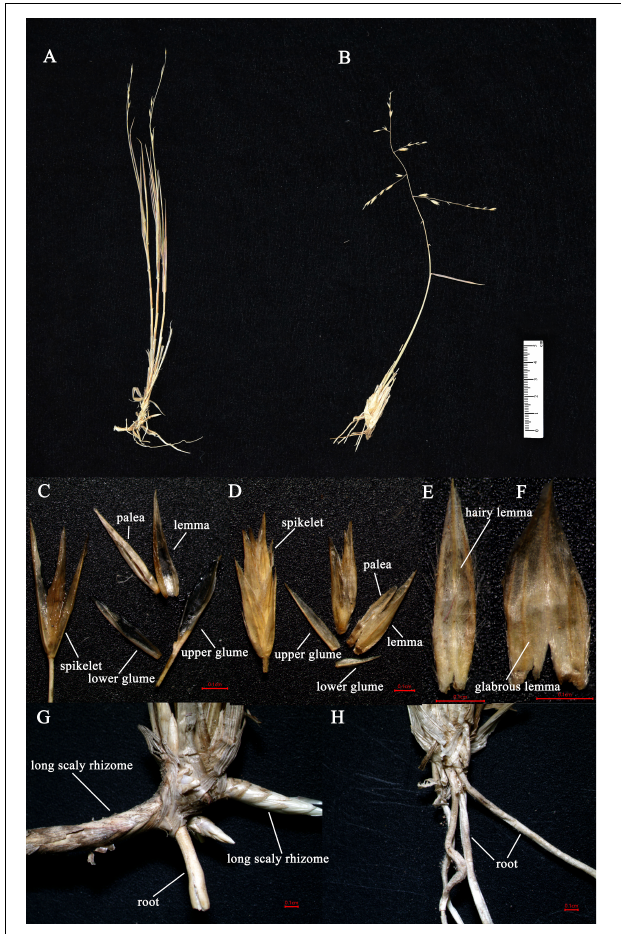
FIGURE 8 | The morphology of O. kokonorica and C. songorica : (A) individual of O. kokonorica ; (B) individual of C. songorica ; (C) spikelet of O. kokonorica ; (D) spikelet of C. songorica ; (E) lemma of O. kokonorica ; (F) lemma of C. songorica ; (G) underground part of O. kokonorica ; (H) underground part of C. songorica